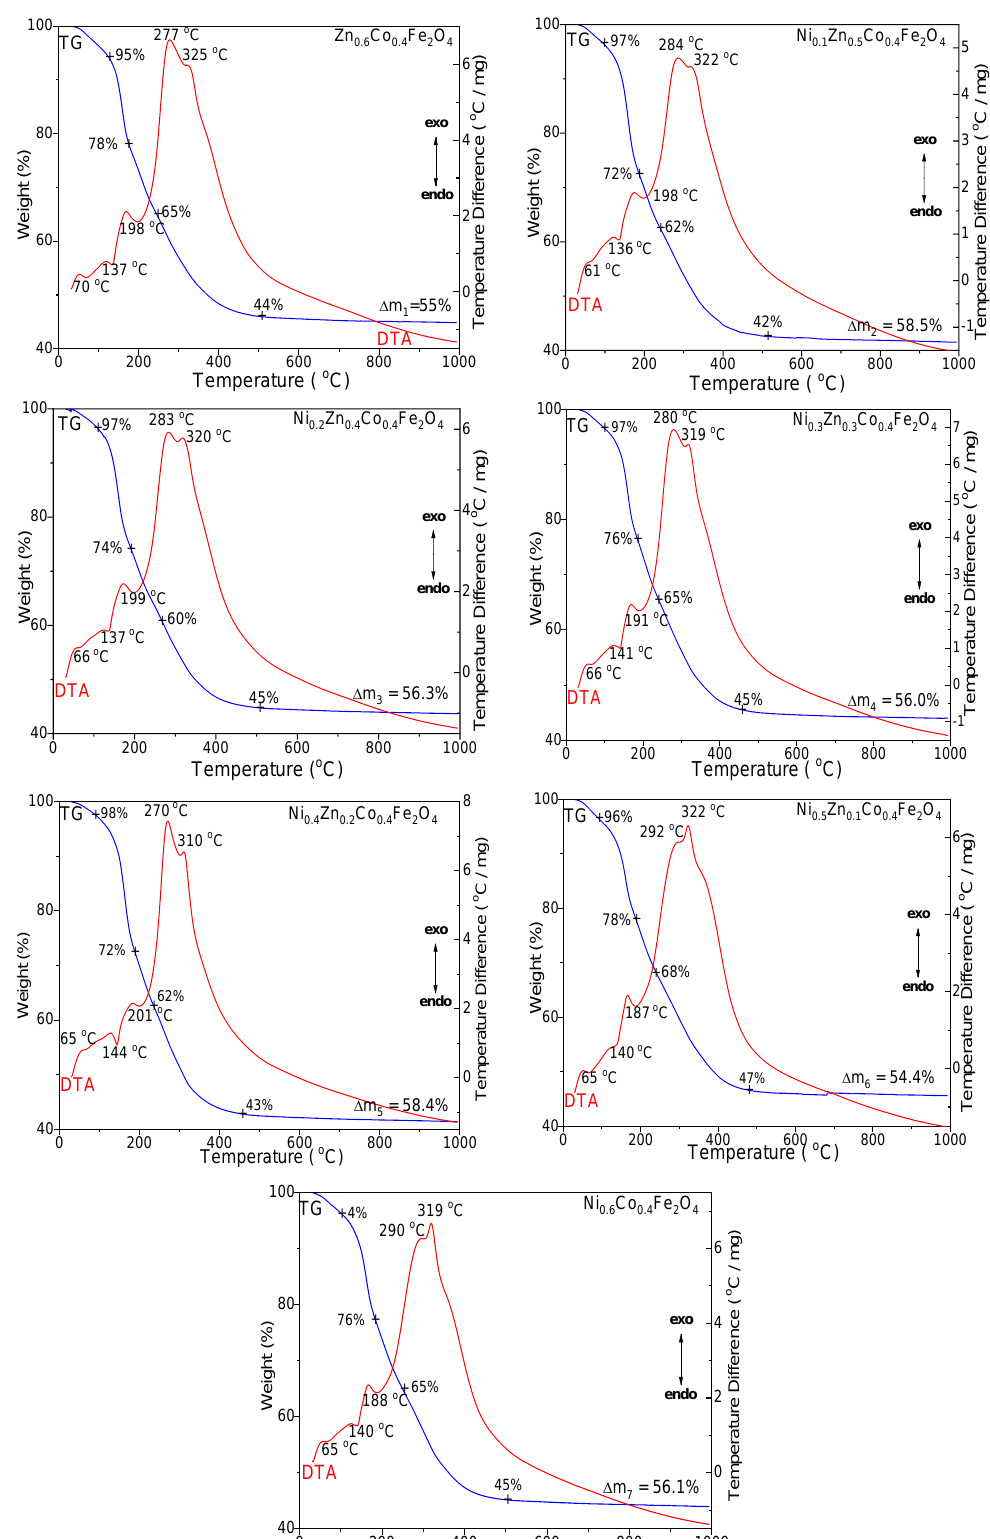
Figure 1. TG-DTA diagrams of Zn 0.6 Co 0.4 Fe 2 O 4 @SiO 2 , Ni 0.1 Zn 0.5 Co 0.4 Fe 2 O 4 @SiO 2 , Ni 0.2 Zn 0.4 Co 0.4 Fe 2 O 4 @SiO 2 , Ni 0.3 Zn 0.3 Co 0.4 Fe 2 O 4 @SiO 2 , Ni 0.4 Zn 0.2 Co 0.4 Fe 2 O 4 @SiO 2 , Ni 0.5 Zn 0.1 Co 0.4 Fe 2 O 4 @SiO 2 and Ni 0.6 Co 0.4 Fe 2 O 4 @SiO 2